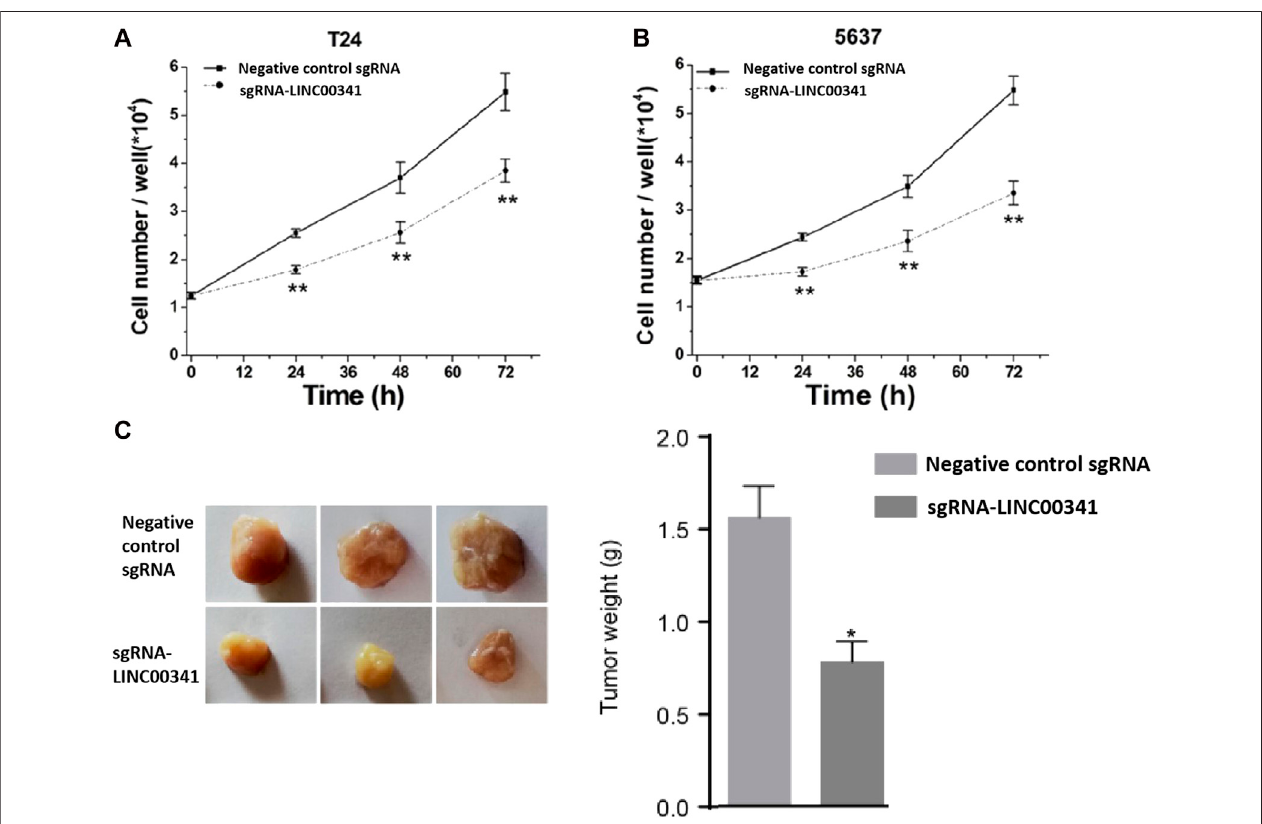
FIGURE2| KnockdownofLINC00341byCRISPR-CasRxsuppressedcellproliferation.CCK-8assaywasemployedtoexplorecellproliferation.Aftertransfection with LINC00341 sgRNA or negative control sgRNA, the OD value was determined and converted into cell number. Analysis of variance is used to compare cell proliferation curves. (A) . There was suppression of cell proliferation in T24 bladder cancer cells (** p < 0.01). (B) . There was suppression of cell growth in 5,637 cells (** p < 0.01). The data is shown as the average ± SD. The experiments were conducted in triplicates. (C) . There was inhibition of tumor growth in vivo in 5,637 bladder cancer cells (** p < 0.01). The data is indicated as the average ±